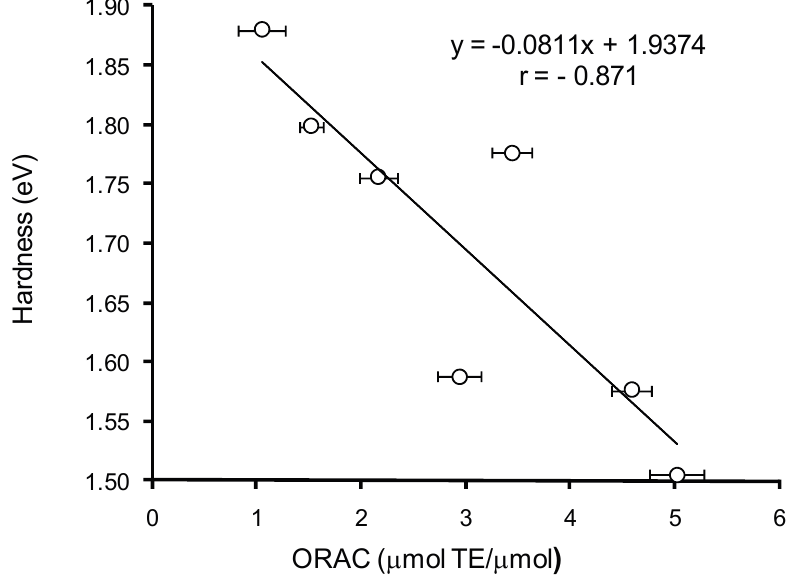
Figure 9. Correlation analysis of AOC against peroxyl radical for HB and HC acids versus rigidity ( η